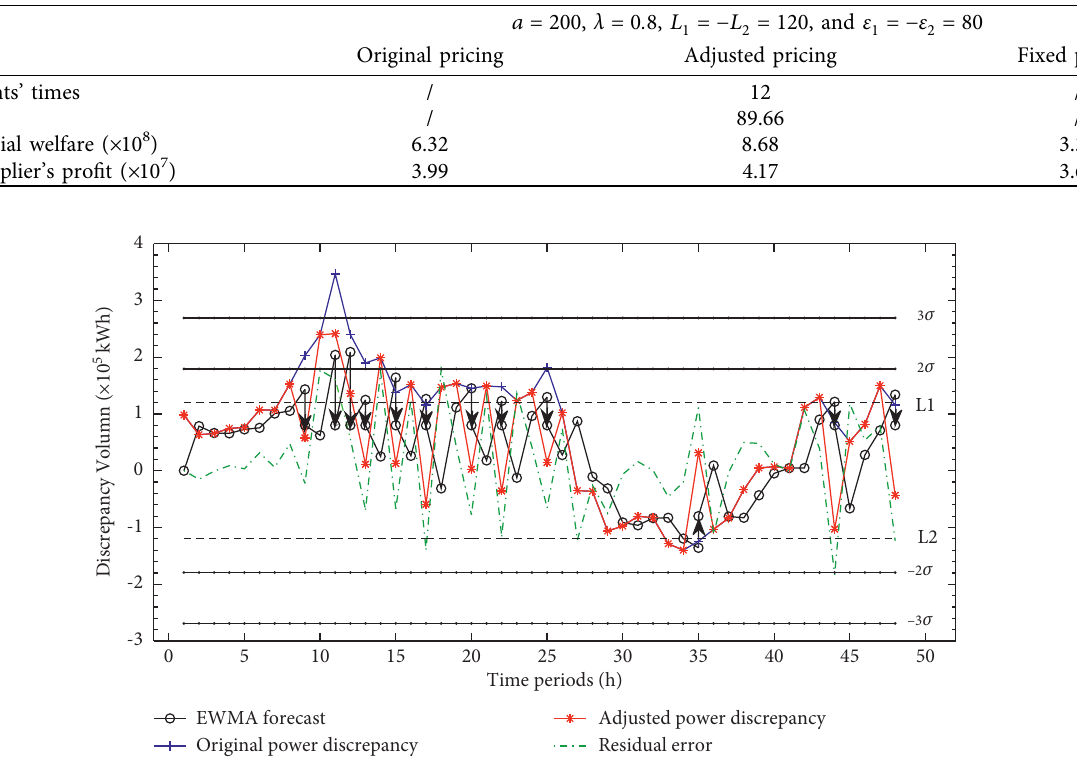
Figure 2: Adjustment effects (black arrows mark the adjustment process, black solid lines with circle markers denote EWMA forecast, blue solid lines with plus sign markers indicate original power discrepancy, red solid lines with asterisks depict adjusted power discrepancy, and green dash-dot lines denote residual error).